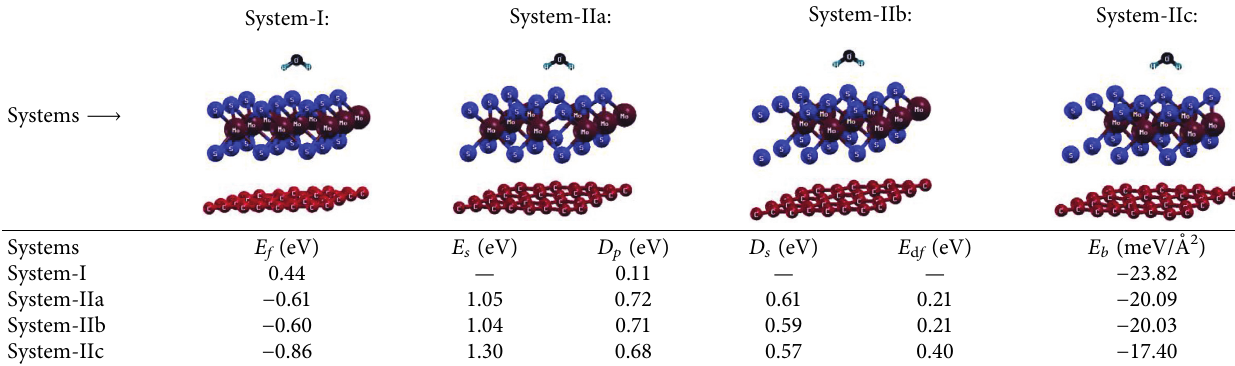
Table 1: Fermi energy ( E f ), fermi energy shifts ( E s ), amplitude of the Dirac point ( D p ), Dirac point shifts in defected materials ( D s ), defect formation energy ( E d f ), and total binding energy of the systems ( E b